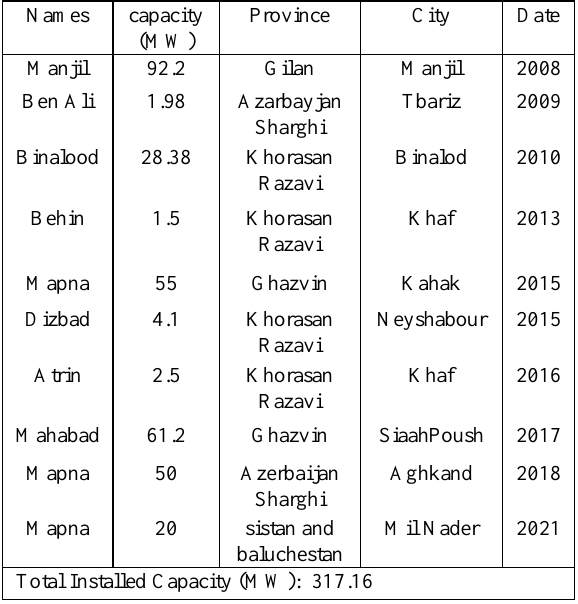
Table 2 . Wind farms in Iran (SATBA).